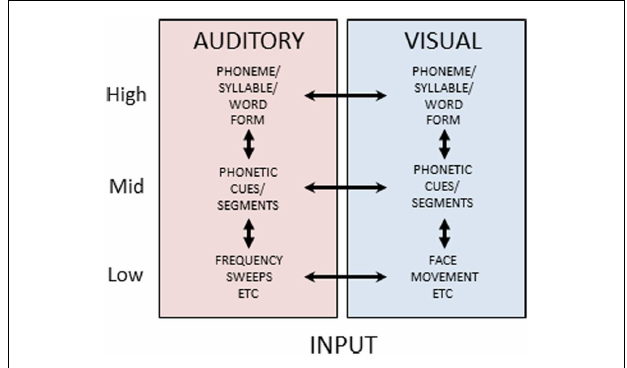
FIGURE 6 |Auditory and visual speech pathways. Figure 6 schematically depicts cortical processing pathways and their interactions for auditory and visual speech. Separate uni-sensory processing pathways are thought to exist for mapping from low-level stimulus features to high-level form-based representations of speech stimuli. During perceptual processing, information is thought to predominantly flow from low-to-high, however feedback pathways are available along both pathways. Additionally, at each level double arrowed lines between the pathways indicate the potential for multisensory integrative